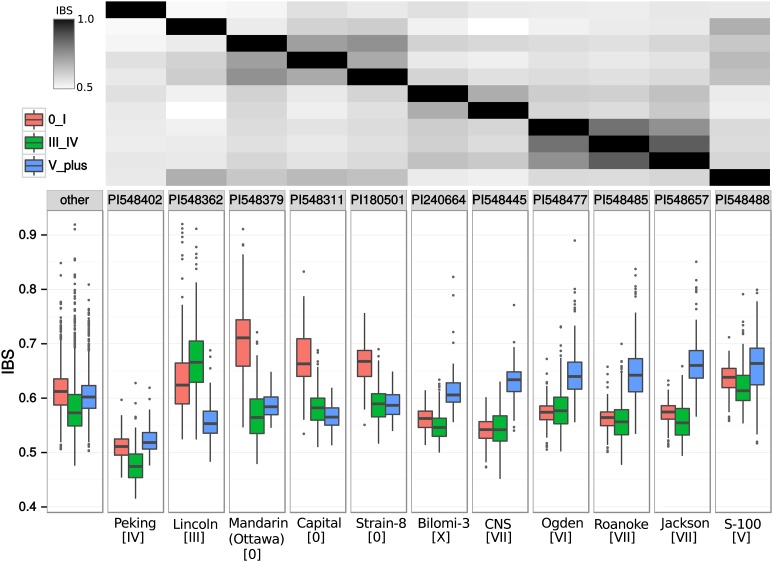
Biased population IBS with major ancestors. For each population, the IBS between each individual and the indicated ancestor is given as a boxplot. Pairwise IBS between each ancestor is shown at the top as a heatmap matrix in which black represents an IBS of 1, or perfect identity. The “other” category represents combined results from all other ancestors in Figure S1. Maturity group of the ancestor is indicated in brackets below name. PI548445 is shown independently because it in an outlier for its low IBS relative to all other ancestors. IBS, identity-by-state.